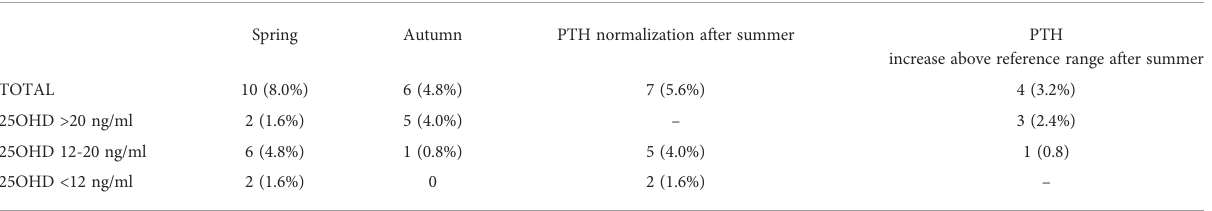
TABLE 3 The number of patients with raised PTH concentrations (65 pg/ml) and normocalcemia depending on the season of the year and 25OHD status. PTH > 65 pg/ml(whole population: n=125, age 6-50, reference range for PTH: 15-65 pg/ml)